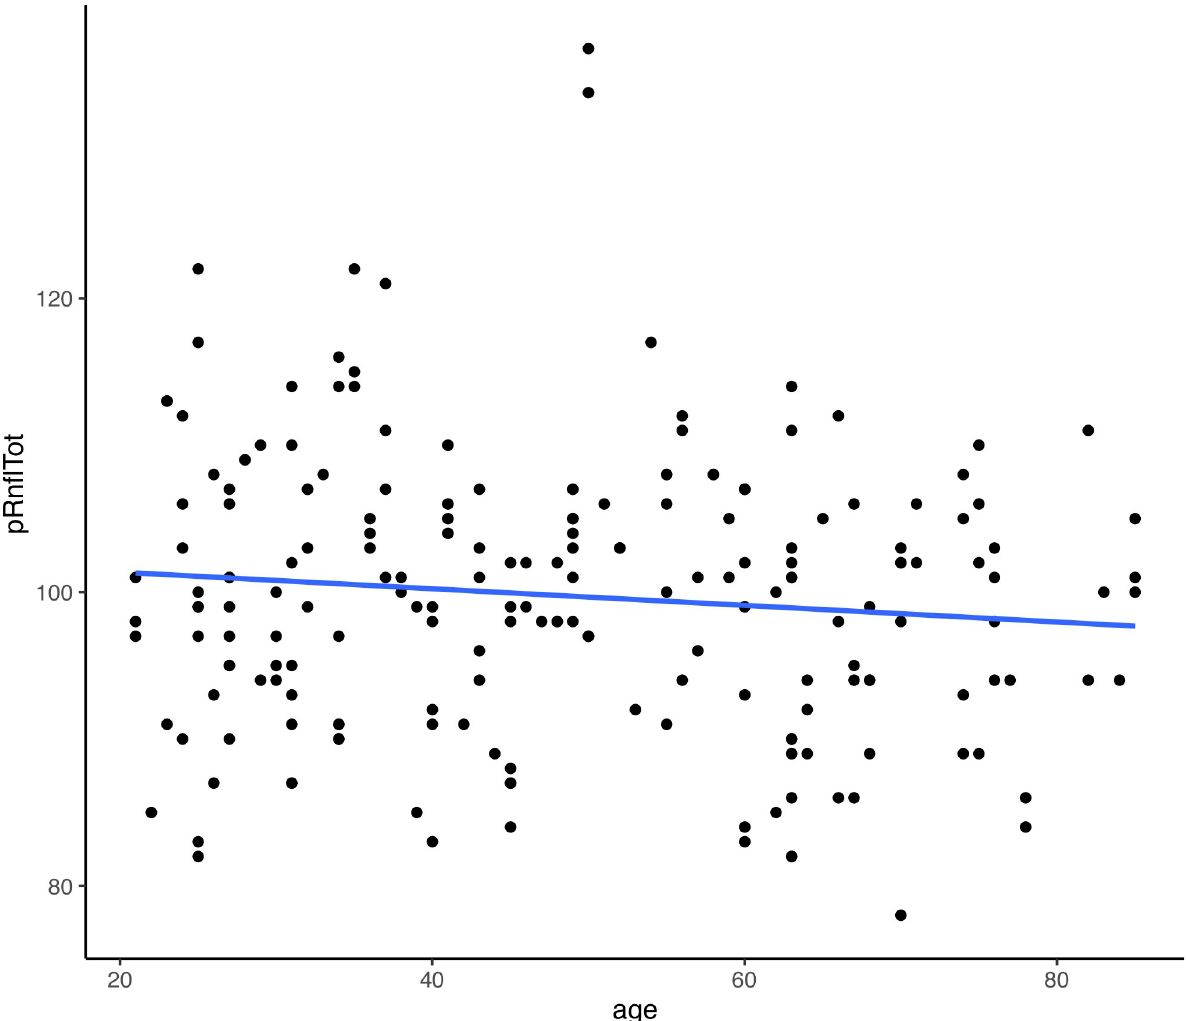
Fig 4. Scatter plot with trend line for mean peripapillary retinal nerve fibre layer thickness against age.